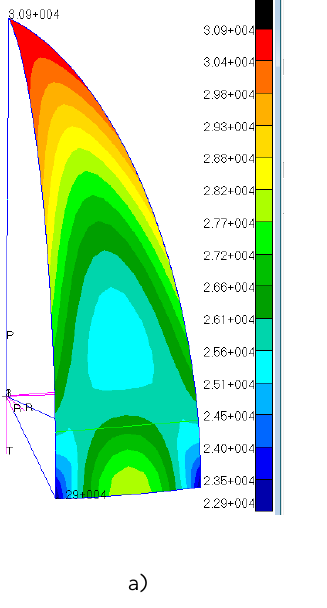
Fig. 30. Principal stresses distribution: over the reflector shell with quasispherical shape lobe, a) principal stress 𝜎 1 , Pa, b) principal stress 𝜎 2 ,